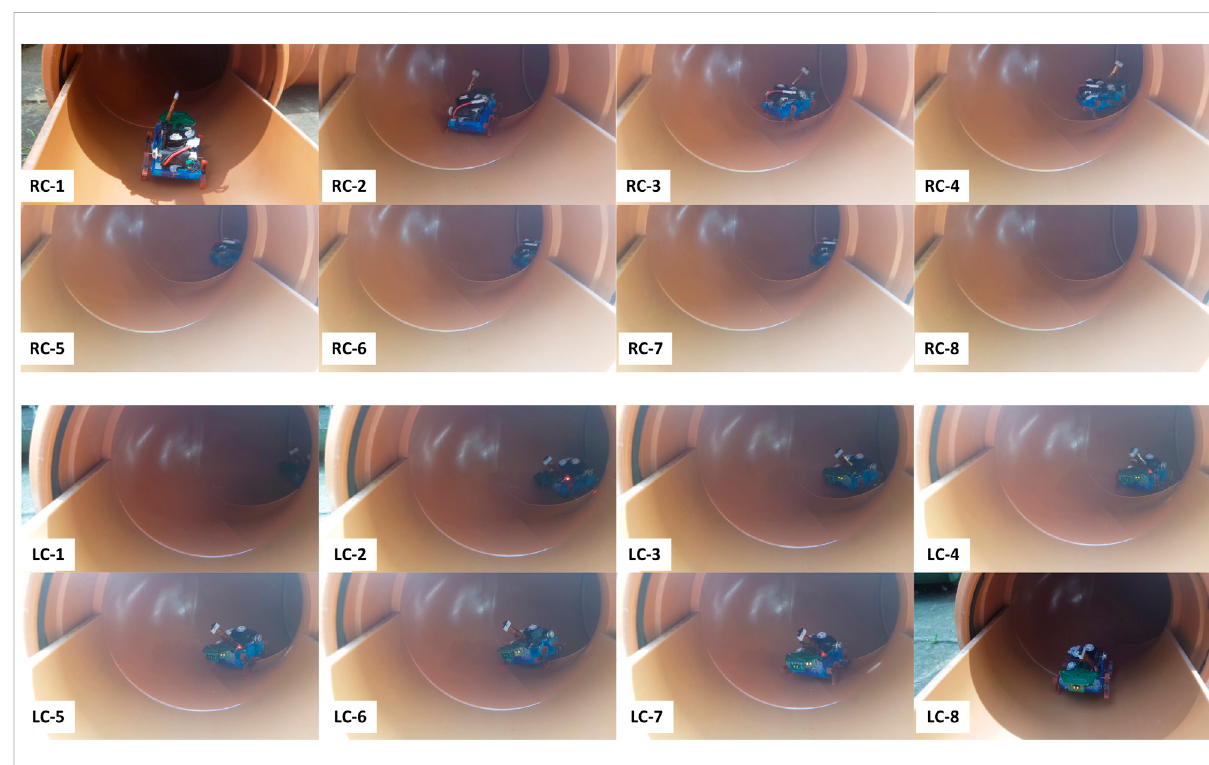
FIGURE 8 Successful detection, decision making and maneuvers of the Joey robot at right (RC-1 to RC-8, top two rows) and left (LC-1 to LC-8, bottom two rows) corners during autonomous pipe